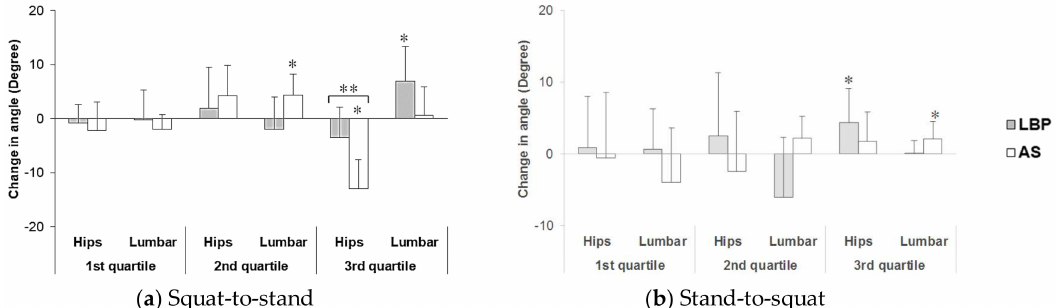
Figure 5. Changes in lumbar spine and hip joint angles (mean ± 1SD) before and immediately after 15 min squatting during ( a ) squat-to-stand and ( b ) stand-to-squat phase. Positive values of the changes indicate an increase in the regional angle (expressed in degree) at post-assessment compared to pre-assessment. * Indicates significant within-group differences and ** indicates significant time × group